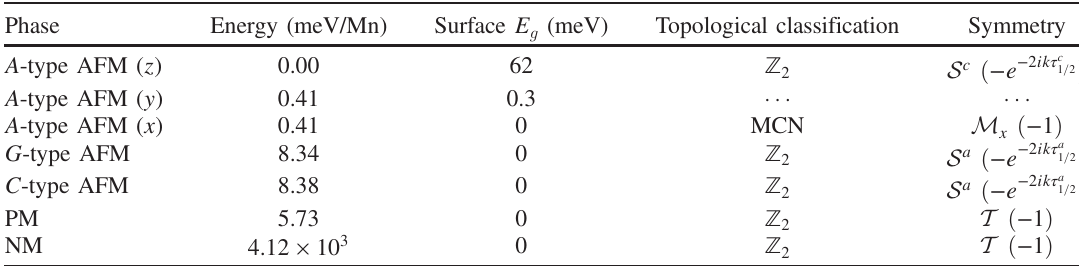
TABLE I. Properties of MnBi 2 Te 4 with different magnetic configurations considered in our work, including the calculated total energy with respect to the magnetic structure of ground state, i.e., A -type AFM ( z ) configuration, the gap size of surface states ( E ), the topological classification, and the corresponding symmetry. The number in g parentheses is the square of the symmetry operation. NM, nonmagnetic; MCN, mirror Chern